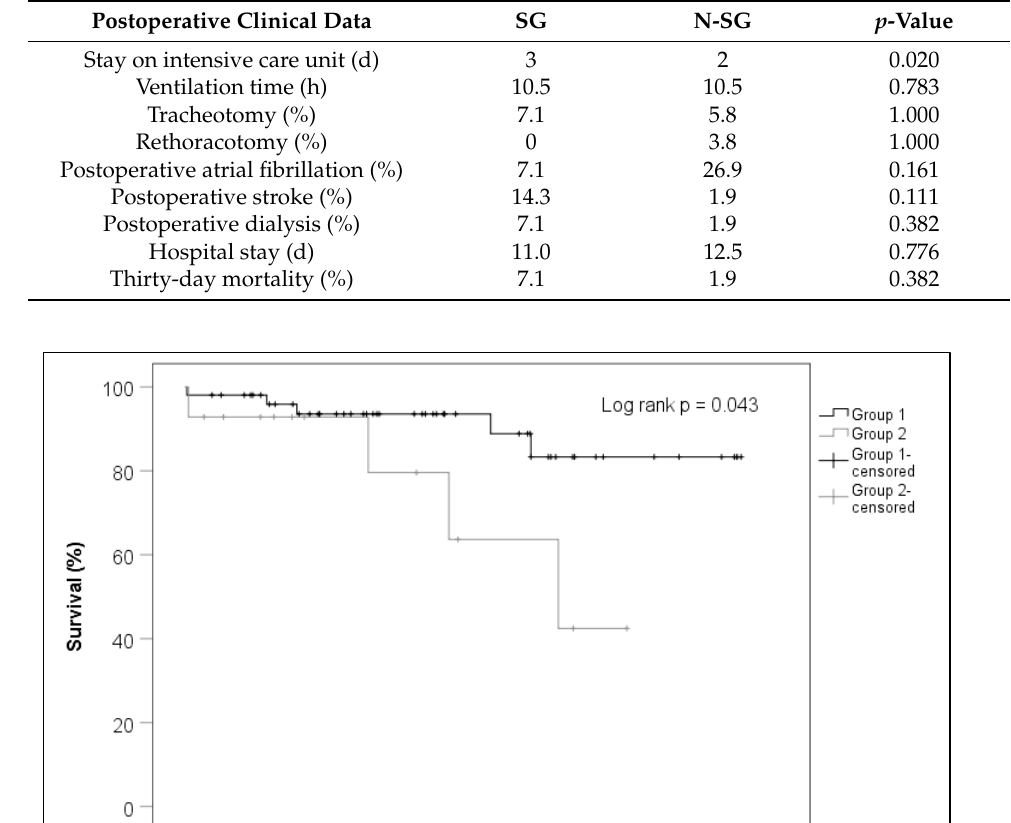
Figure 5. Criteria combination of CM in the N-SG vs. SG. Table 7. Postoperative clinical data.